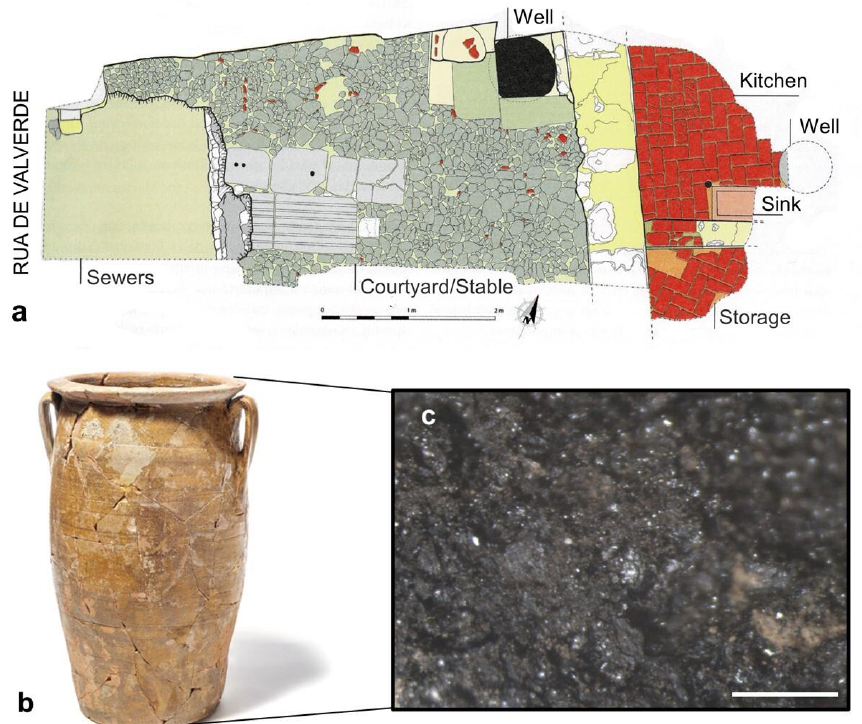
Figure 2. ( a ) Plan of the excavated sectors of the house destroyed by the Great Lisbon Earthquake [51]; ( b ) cylindrical vessel (PDPIV’17.16) recovered from the storage area (© CML | DMC | DPC | José Vicente 2020); height: 46 cm, width: 25 cm; ( c ) organic residue found in the vessel.